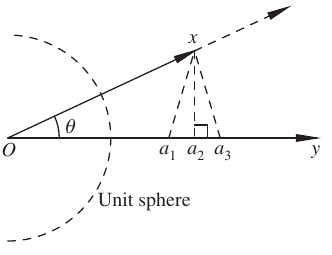
Figure 2. Geometrical Explanation to Eq.